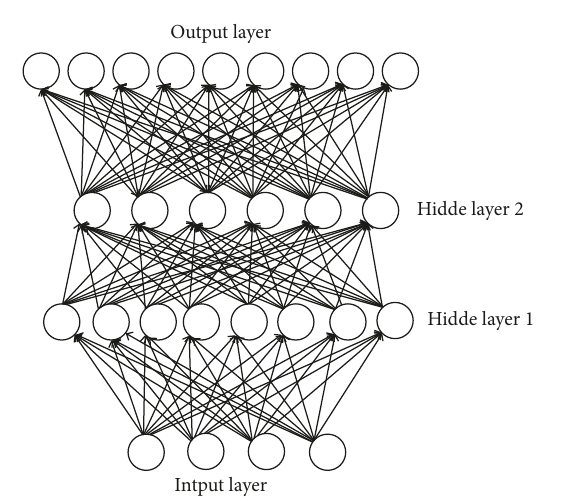
Figure 10: Structure of BP neural